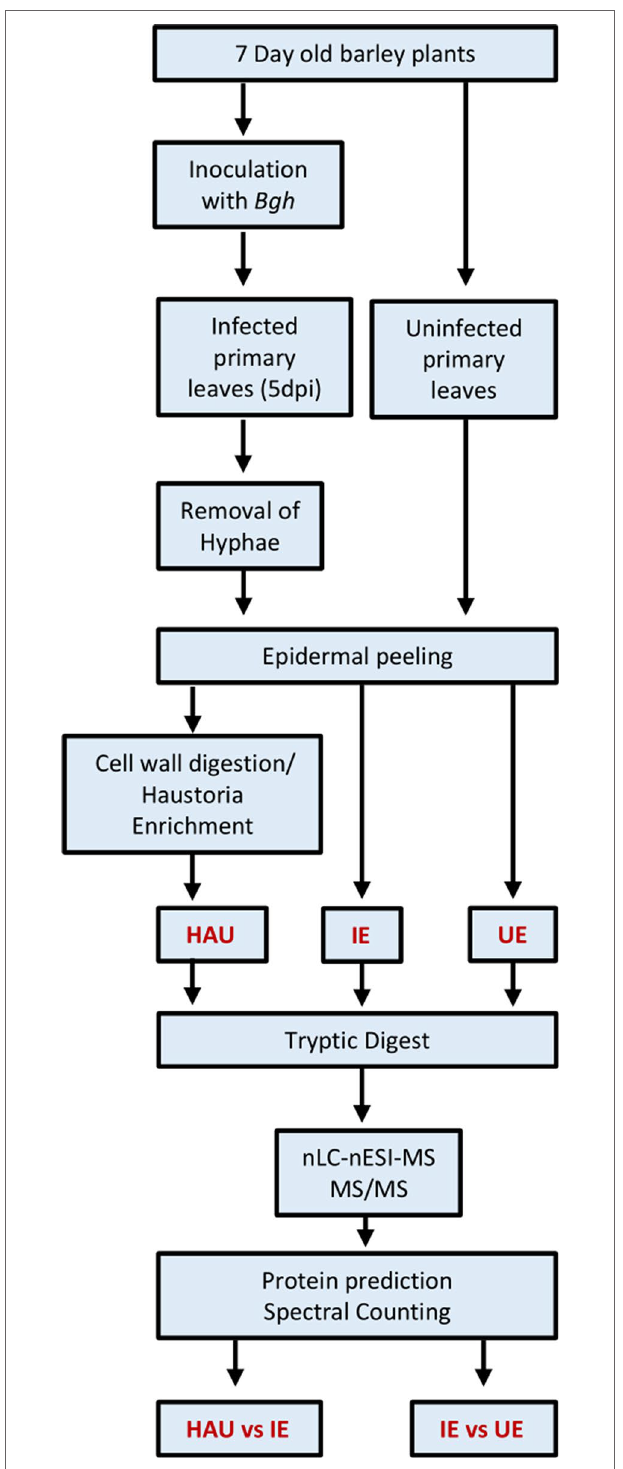
FIGURE 2 | Workflow used to prepare the three types of barley protein samples for proteomics investigation: uninfected epidermis (UE, four biological replicates), infected epidermis (IE, four biological replicates), and enriched haustoria from infected epidermis (HAU, three biological replicates). Powdery mildew infected barley leaves were collected at 5